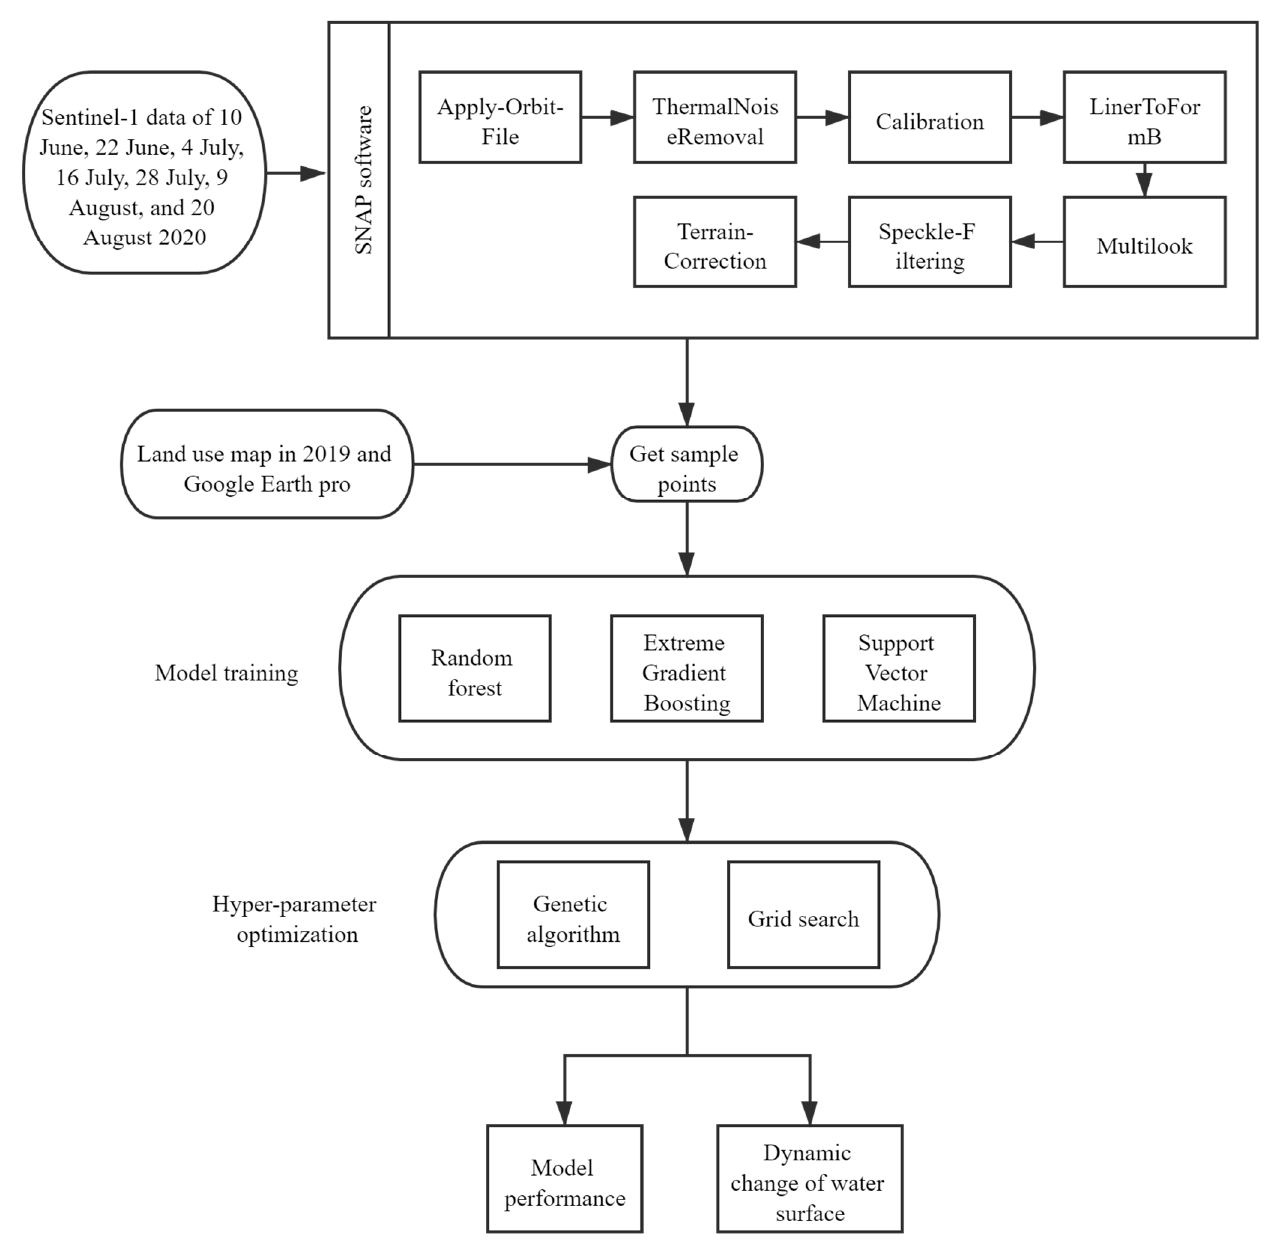
Figure 1. Overall Figure 1. Overall workflow.